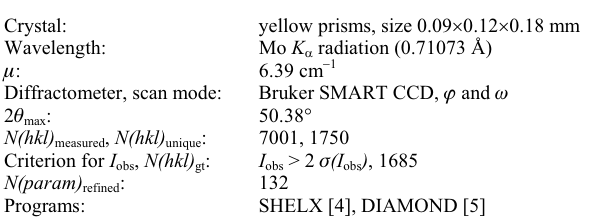
Table 1. Data collection and handling.